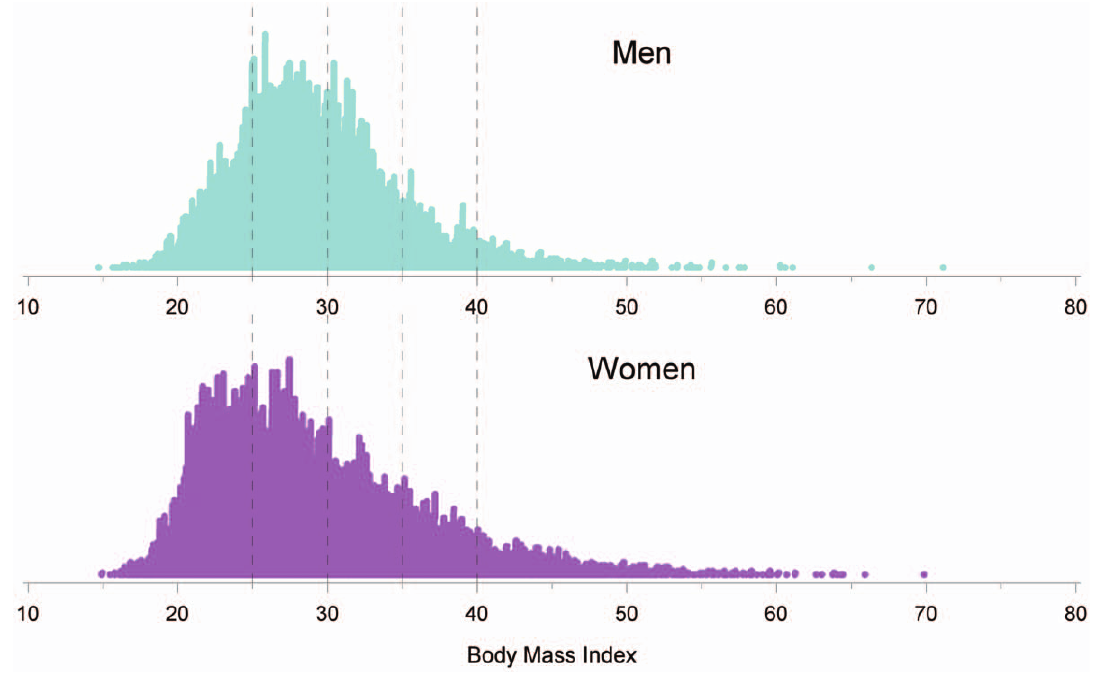
Figure 1. Gender stratified distribution of Body Mass Index (BMI) within the entire population-based PMRP biobank. All subjects with BMI . 40 kg/m 2 (n=477 female participants, and 168 male participants) were included in the current study cohort.